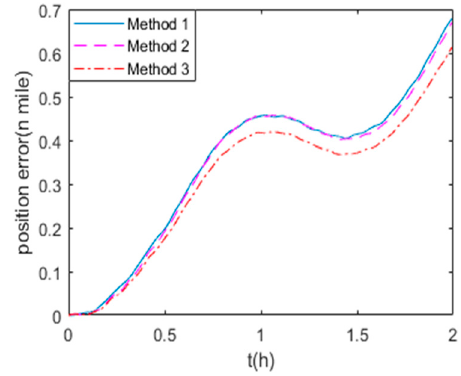
Figure 8. The navigation errors in state (1) .